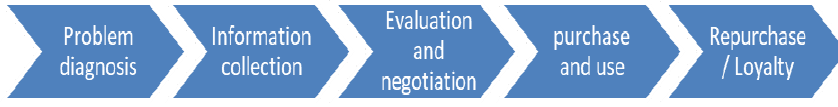
Figure 1. example of a B2B customer journey